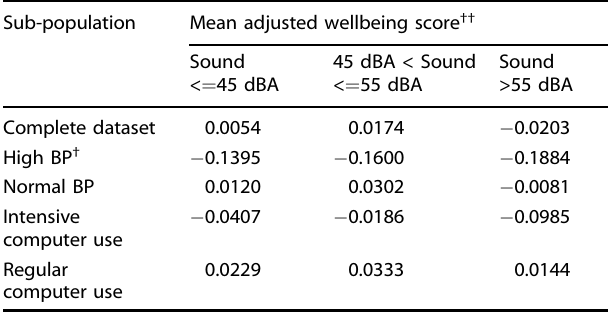
Table 6. Post-hoc group comparisons across sound level